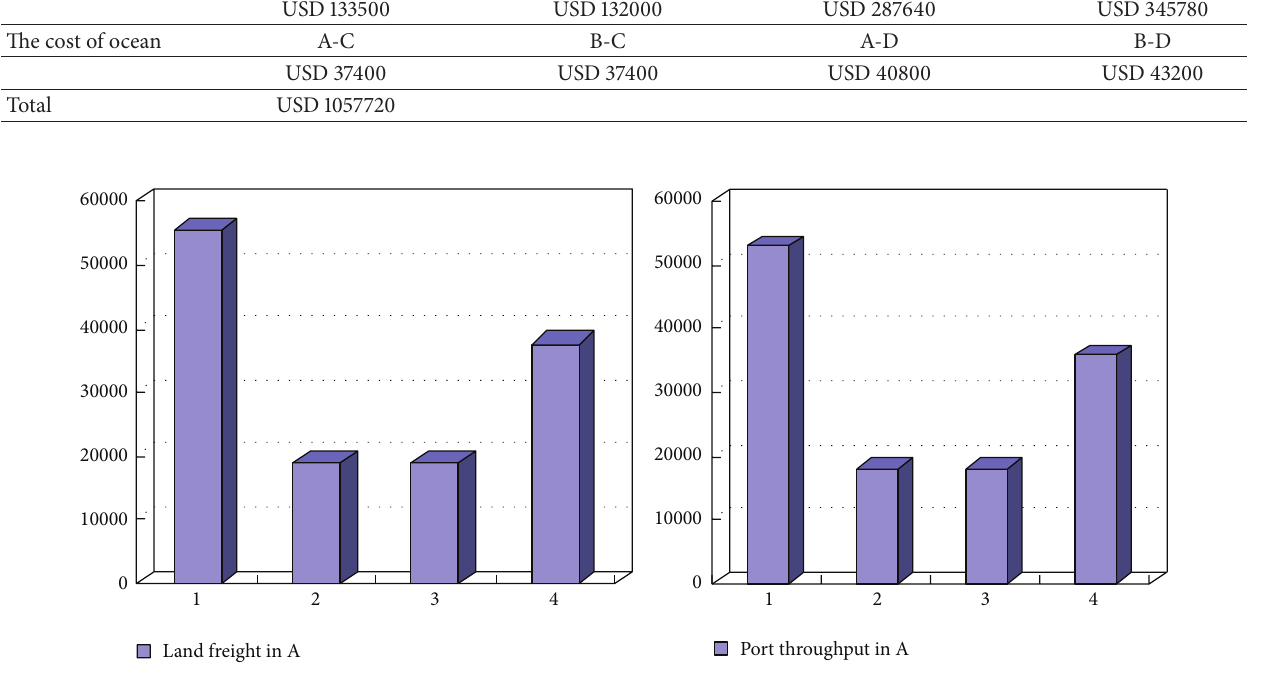
Figure 5: Freight volume of A in different schemes.